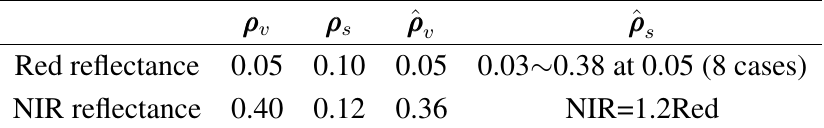
) and non-vegetation ( ρρρ ) surfaces v s